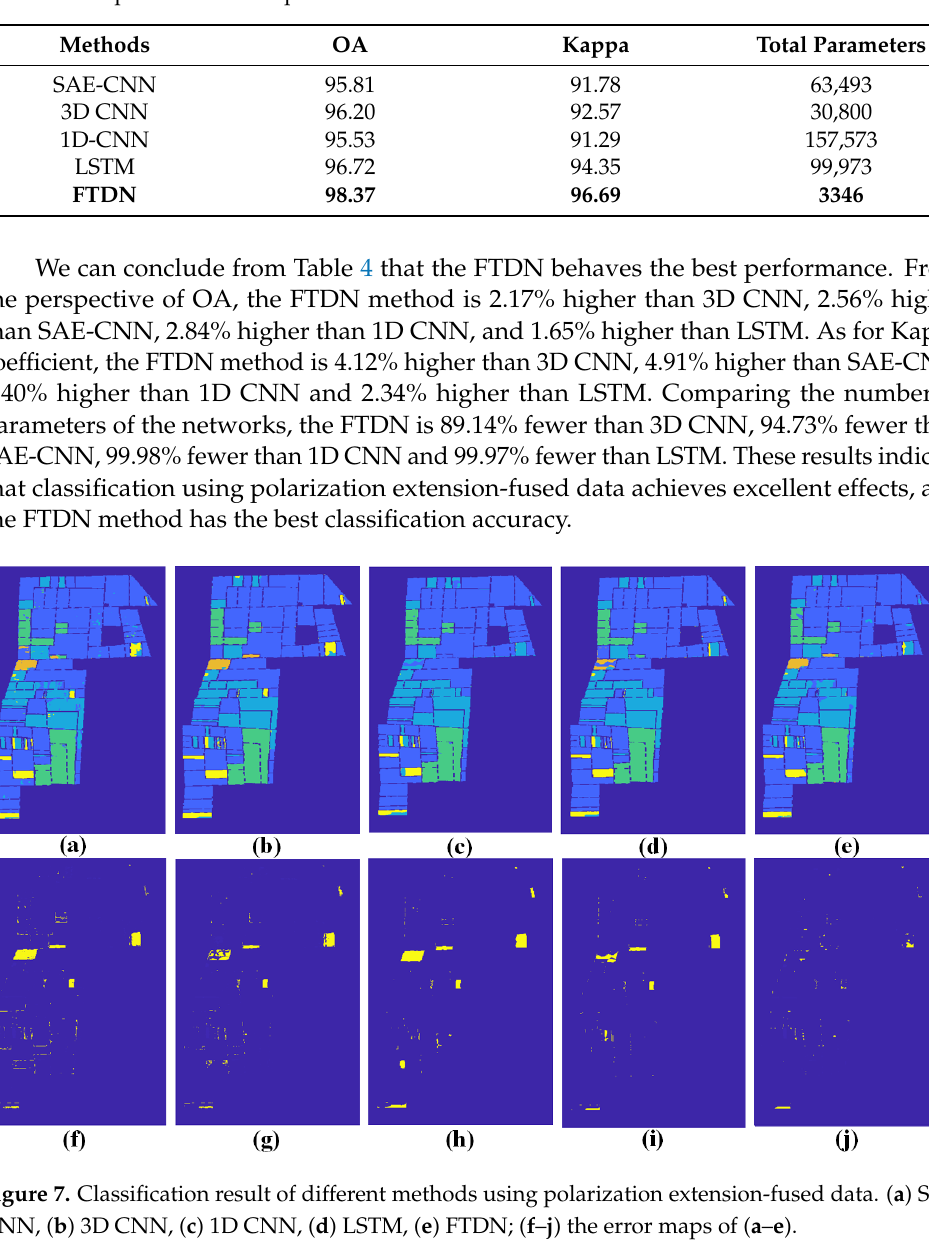
Table 4. Comparison between polarization extension-fused data classified.